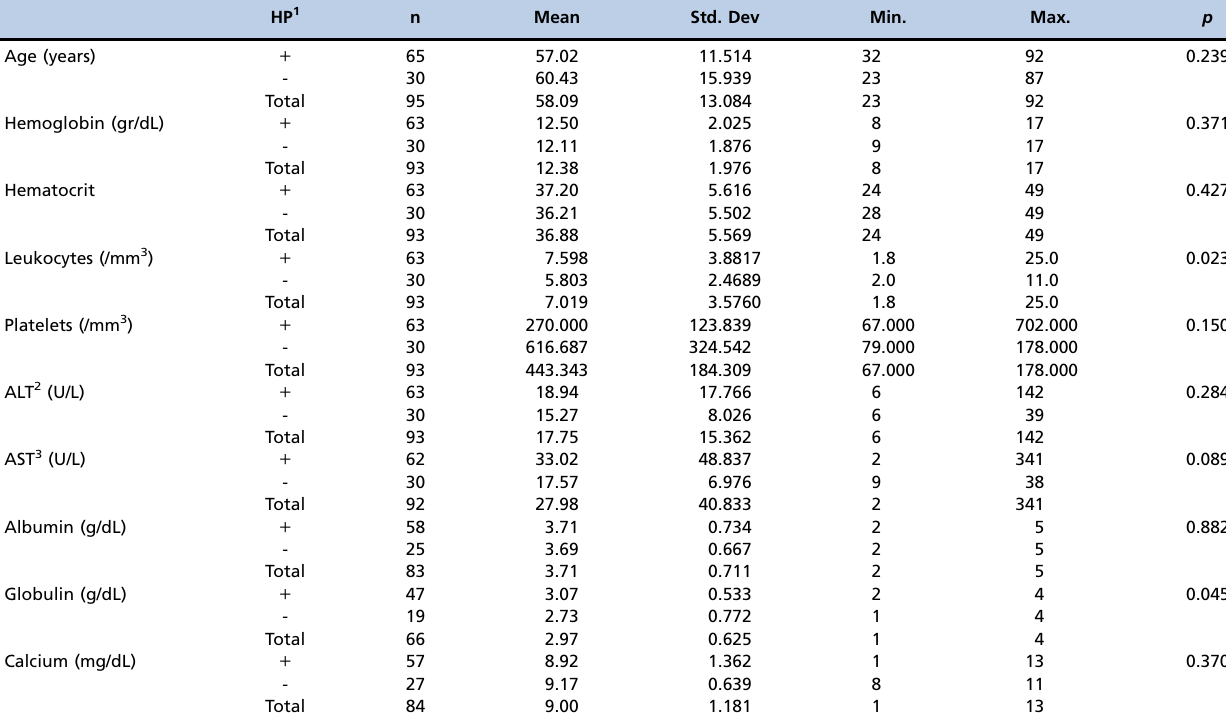
Table 1 - Descriptive statistics and comparison results according to Helicobacter pylori status. HP